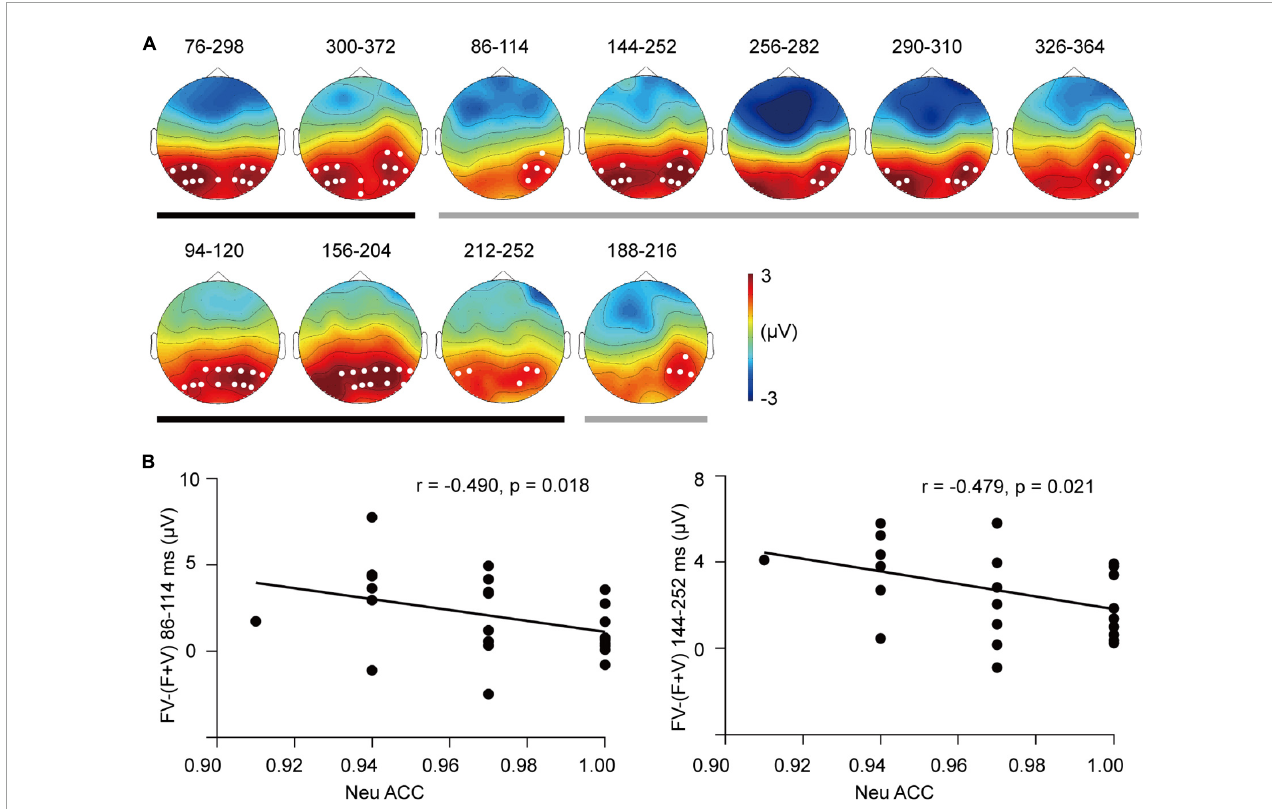
FIGURE6 The superadditivity of ERP clusters. (A) The topographies and their corresponding time windows (ms) for the clusters of superadditivity for the SAD (up row) and HC groups (bottom row). Black line: Angry trials; gray line: Neutral trials. (B) Scatter plots of the categorization accuracy in response to neutral bimodal combinations and superadditive response [FV–(F + V)] in the clusters during 86–114 ms (left) and 144–252 ms (right) for the SAD